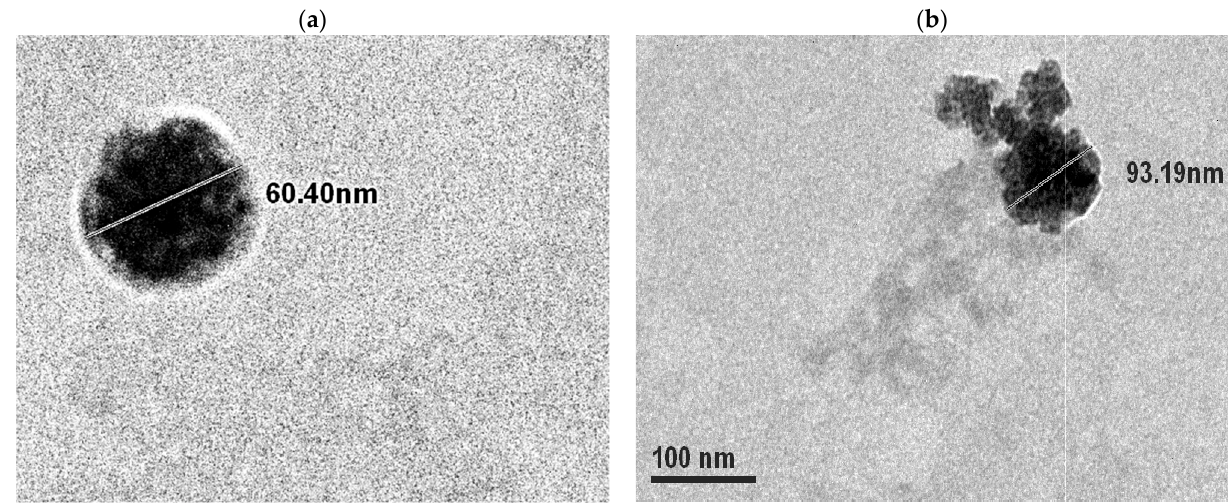
Figure 1. TEM image of ISM SANPs displaying size and morphology of NPs (60.4 nm and 93.19 nm diameters in figures ( a , b ), respectively. The polymeric covering of white color is also depicted in these figures. Figure 1b shows ISM release).